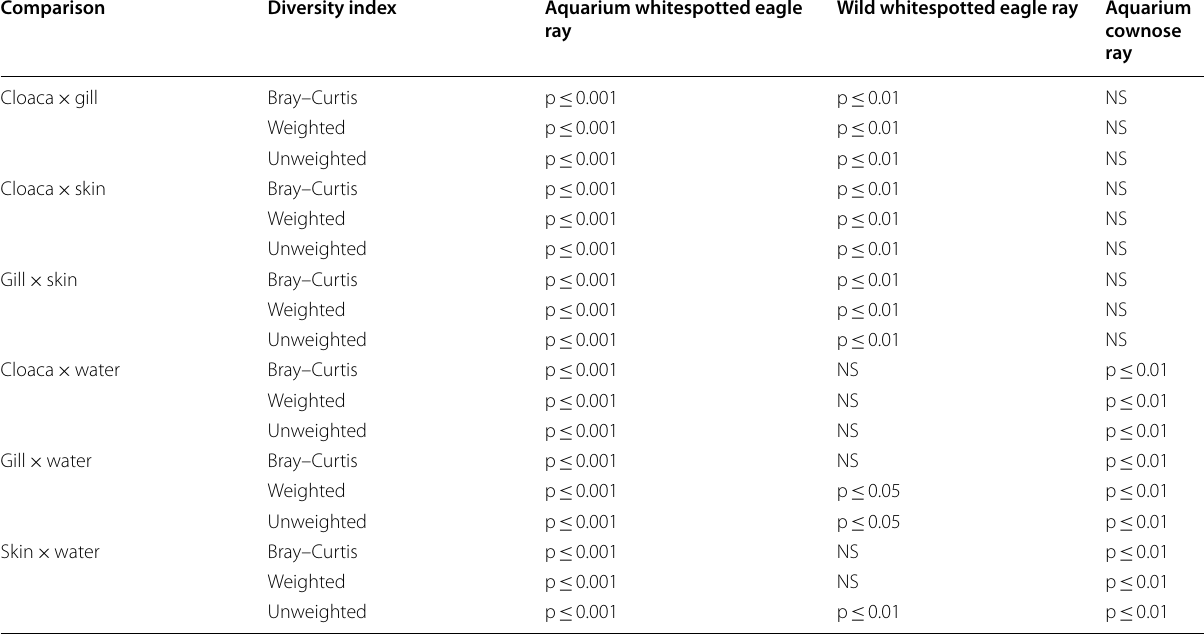
NS indicates no significant (p >